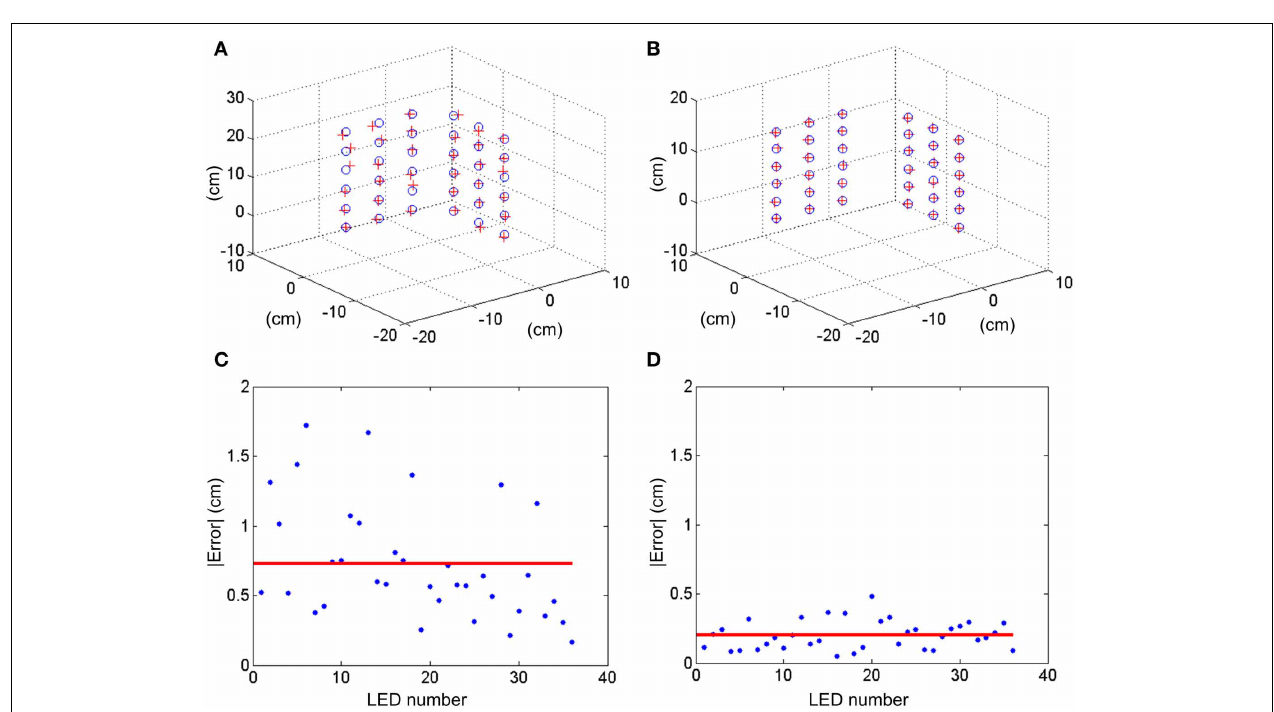
FIGURE 8 | 3D reconstruction of the coordinates of the calibration LEDs. (A) With pixel resolution and (B) with sub-pixel resolution. Blue circles represent the real location of the LEDs, while red crosses indicate